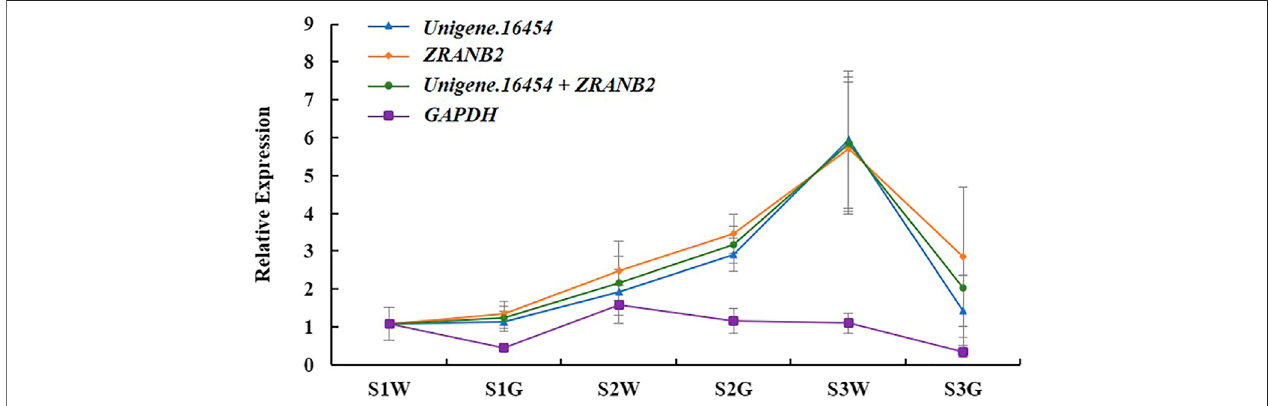
FIGURE5| Relativeexpressionpatterns of HEMC .S1W,S2W,andS3WmeanwhitepartsofchimericleavesatS1,S2,andS3,respectively.S1G,S2G,andS3G mean green parts of chimeric leaves at S1, S2, and S3, respectively. Error bars for RT-qPCR show the standard deviation of three replicates.